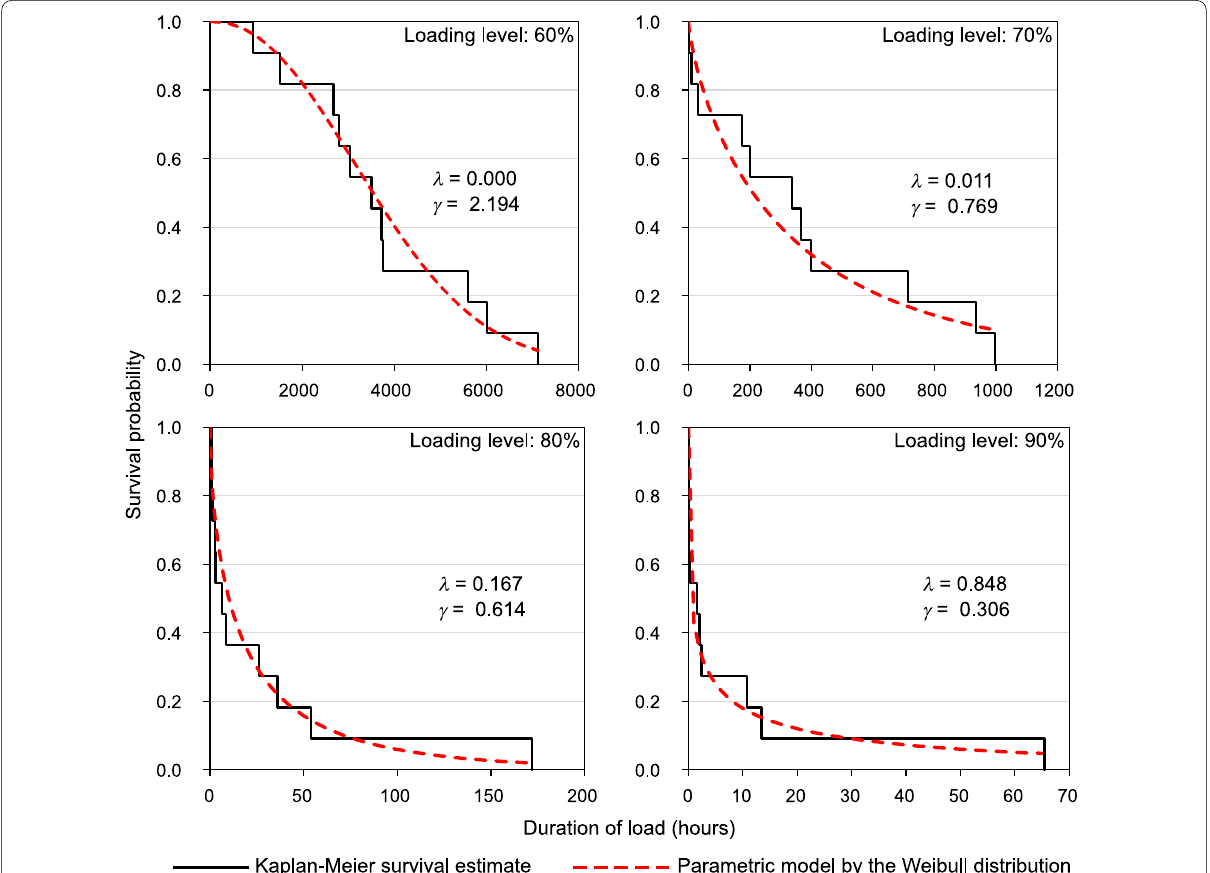
Fig. 8 Results of the survival analysis. λ and γ are scale and shape factors of the Weibull distribution, respectively (see Eq.